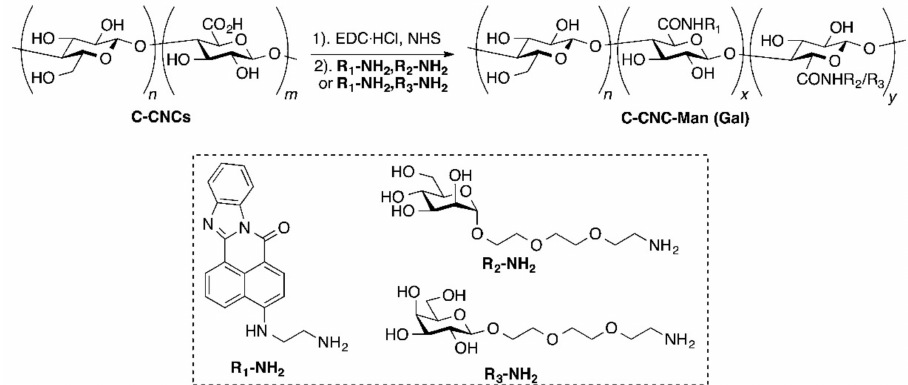
Scheme 11. Synthesis of carbohydrate-functionalized and fluorescent cCNCs (Reproduced with permission from [79], Copyright: American Chemical Society